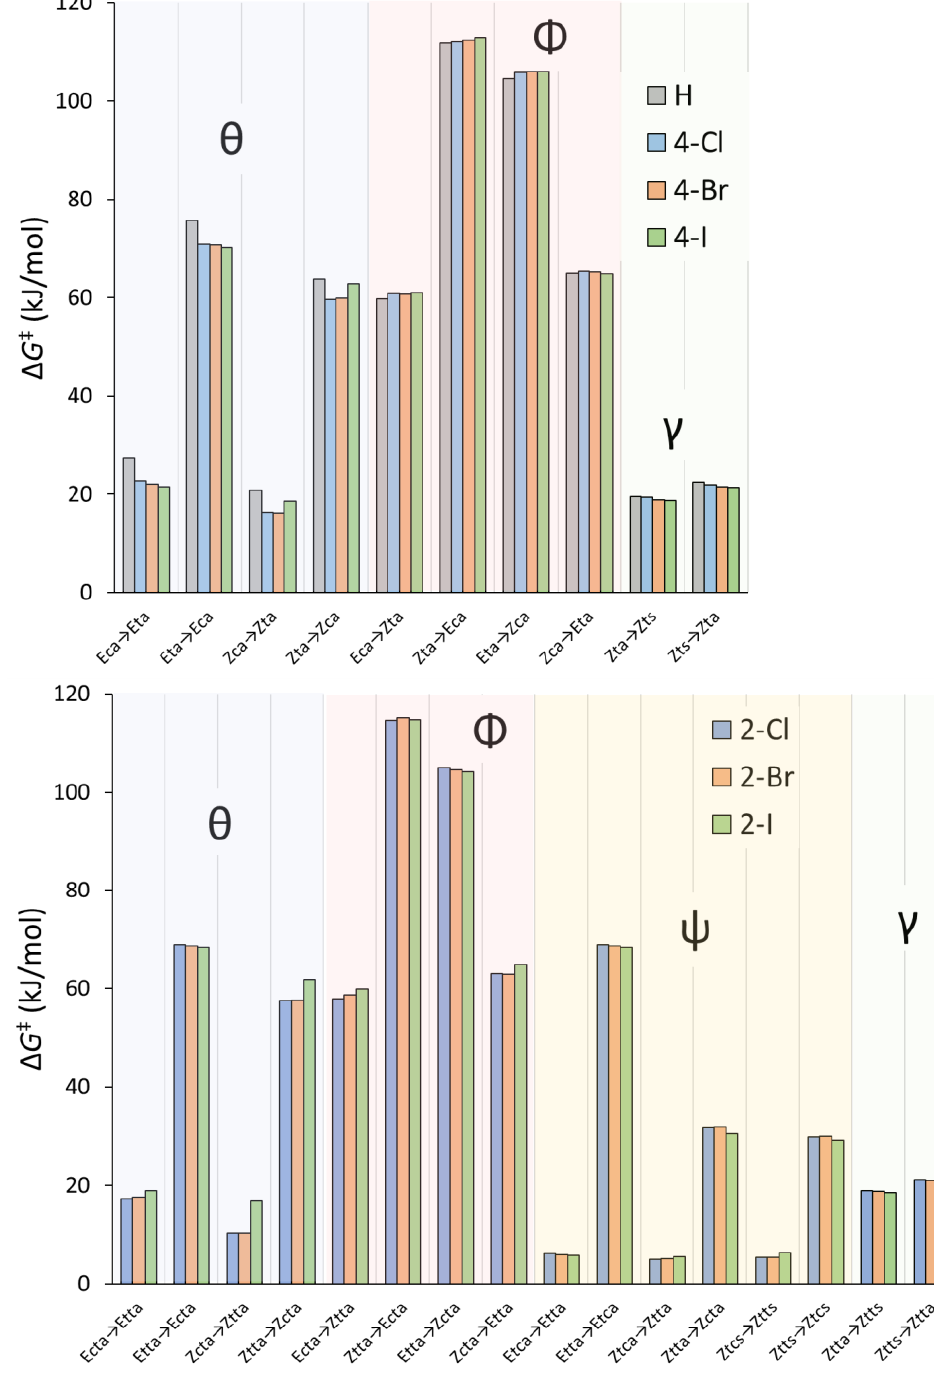
Figure 19. Activation barriers, ∆ G ‡ , of the isomerization processes of 1 – 7 at 298 K, calculated at the ω B97M-D4/cc-pVTZ level of theory. The barriers are grouped as to the isomerization type. The vertical lines are just a guide for the eye.